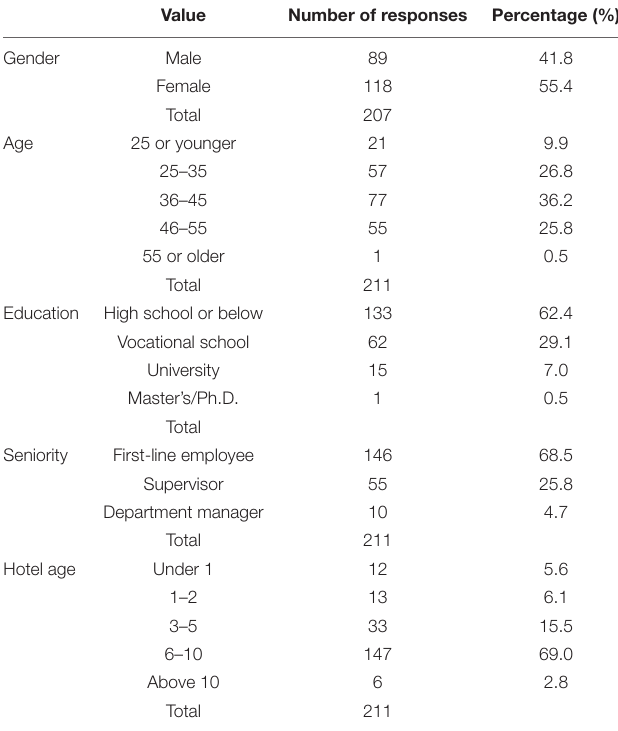
TABLE 1 | Characteristics of the respondents ( n =